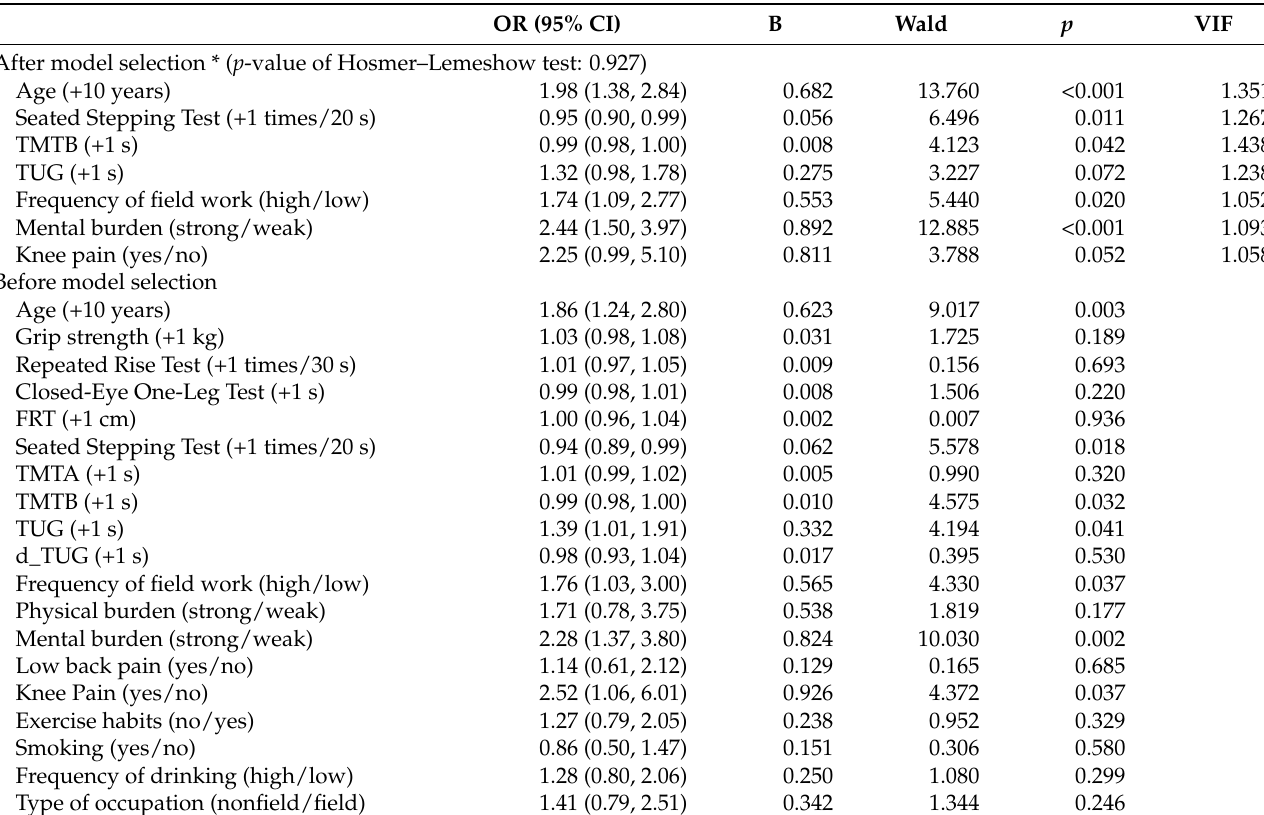
Table 5. Odds ratios and 95% confidence intervals for stumbling after and before model selection in men. OR (95%